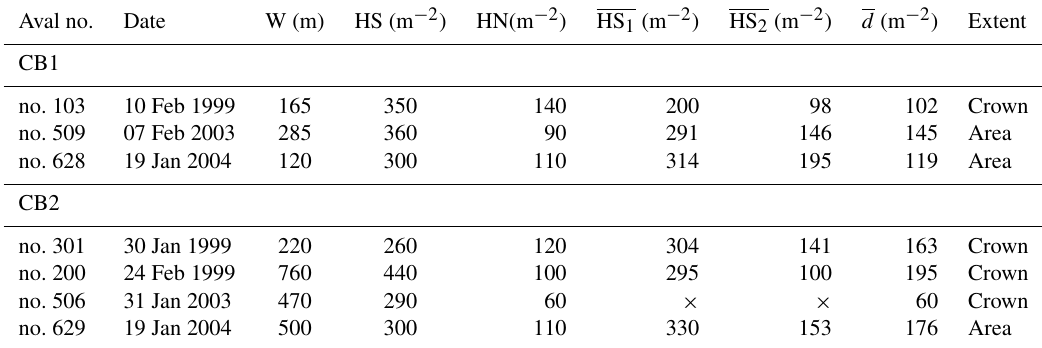
Table 1. Number, date, release area width ( W ), snow depth (HS) and new snow depth (HN) measured at the weather station of Donin du Jour; mean snow depth before (HS 1 ) and after avalanche release (HS 2 ) and mean fracture depth ( d ) for avalanche release areas occurring before the winter season 2005 / 2006. Further, the spatial measurement extent is provided. Aval no.